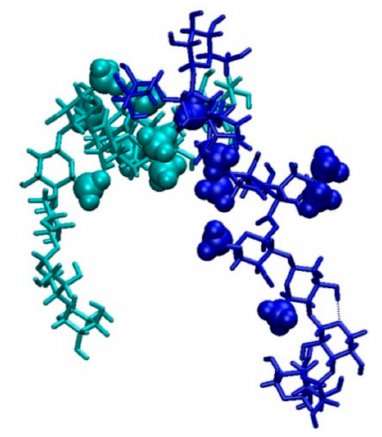
Figure 5. Radial pair distribution function for methyl carbon atoms of the aglycone moiety and methyl carbon atoms of rhamnose and fucose residues. The presented curve is an average over three independent simulations (system I–III, see Table 2).